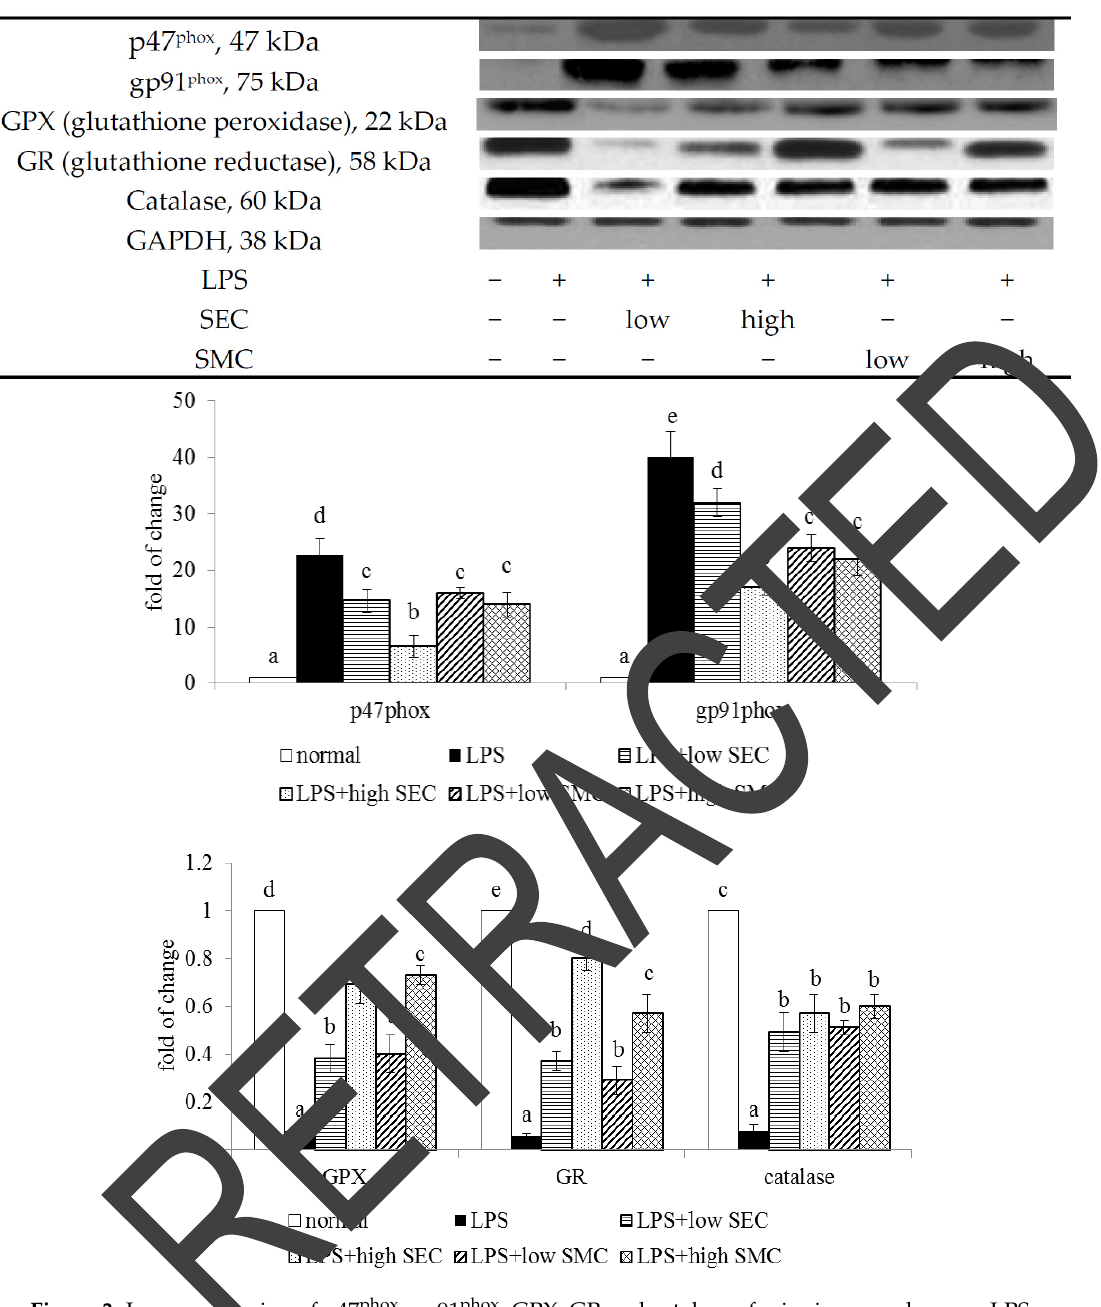
Figure 3. Lung expression of p47 phox , gp91 phox , GPX, GR and catalase of mice in normal group, LPS group, LPS + low SEC group, LPS + high SEC group, LPS + low SMC group and LPS + high SMC group after 3-day treatments. Data are mean ± SD, n = 10; a − e Means among bars without a common letter differ, p < 0.05.